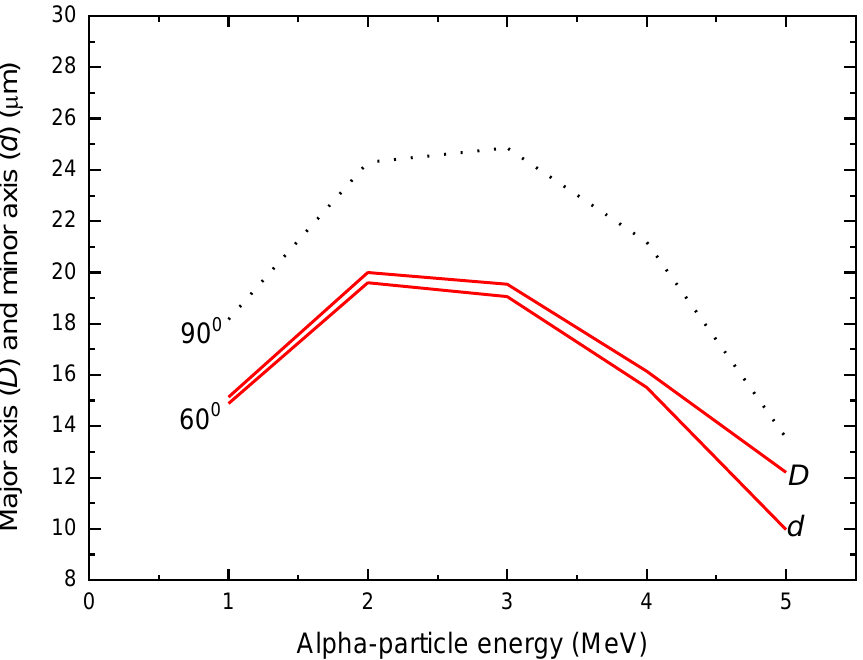
Figure 2. Relationships between the lengths of the major axis D and minor axis d of the elliptical track openings in the Makrofol detector and the alpha-particle energy for both incident angles of 90° and 60° for the PEW (potassium, ethanol and water) etchant (15-g KOH + 45-g H 2 O + 40-g ethyl alcohol), V b = 15 μ m/h and 2 h of etching.